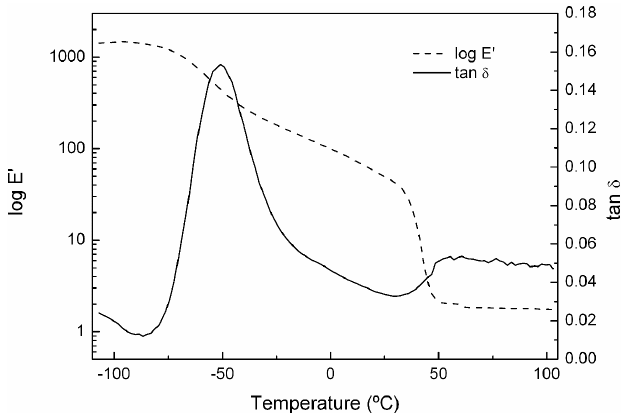
Figure 5. Evolution of tan δ and log E’ with temperature for PCO+2%DCP sample.